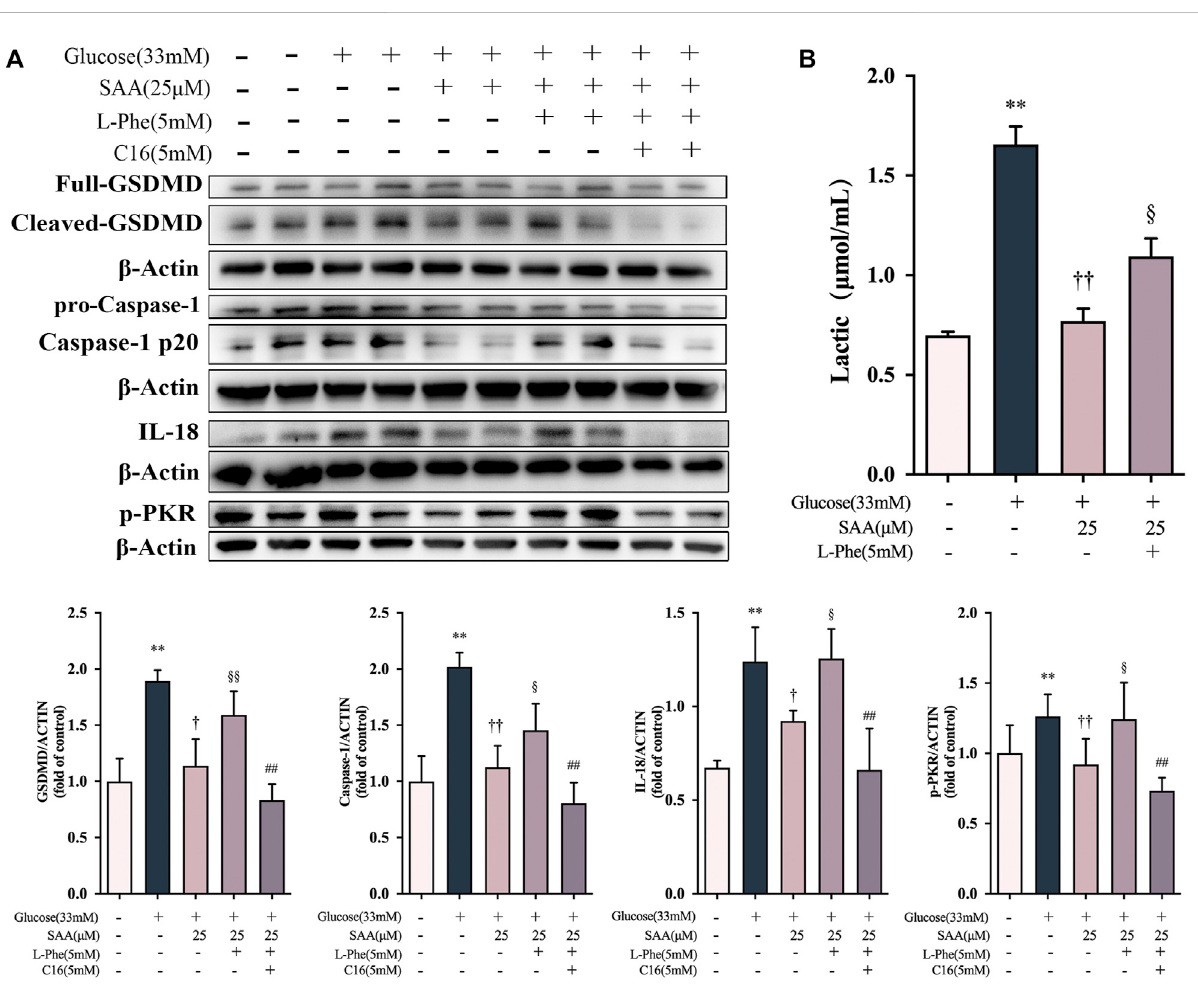
SAA protected the endothelial cells against high glucose-induced pyroptosis in a PKM2/PKR-dependent manner. (A) Expression levels of caspase-1, GSDMD, IL-18, and ß -ActininHUVECswere determined by western blot. (B) Expression levels of pPKR, PKR and ß -Actin inHUVECswere determined by western blot. (C) Lactate levels in HUVECs. Data of western blot are the representatives of four independent experiments. Date of histogramsarerepresentedasmean±SDofthreeindependentexperiments.* p < 0.05,** p < 0.01vs.controlgroup. † p < 0.05, †† p <